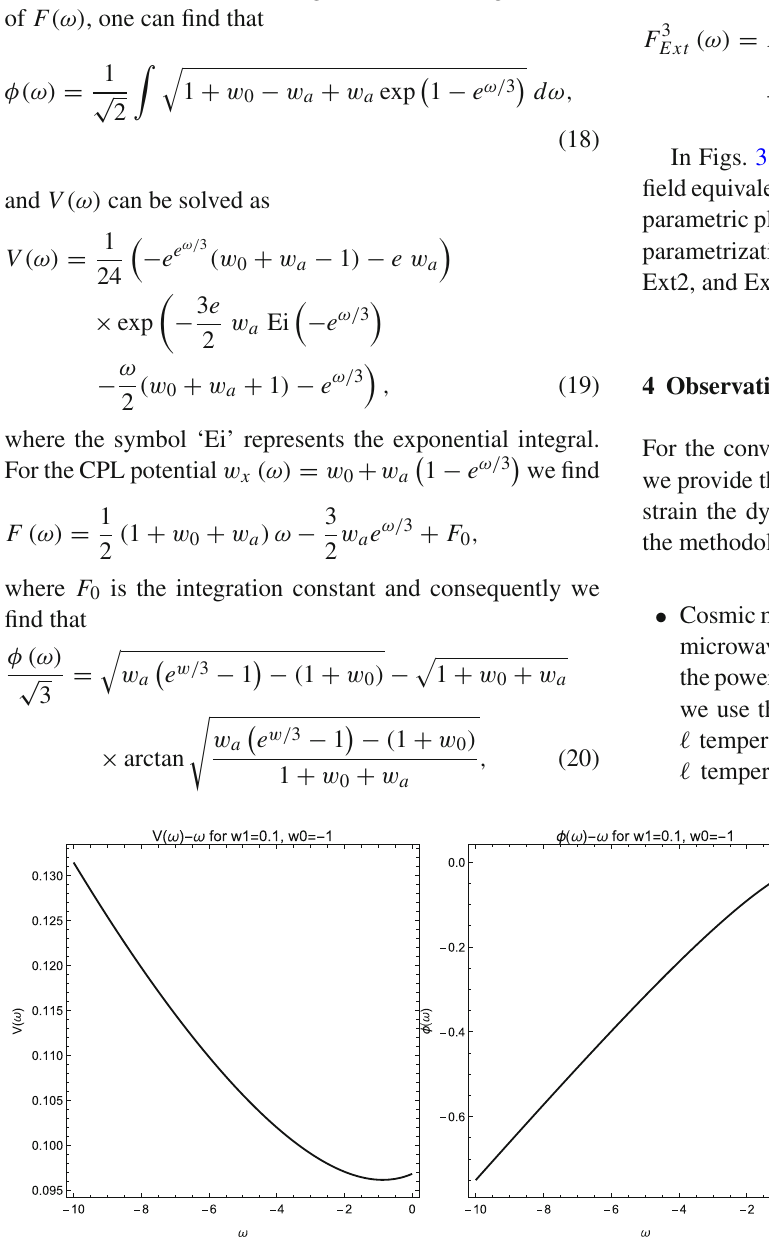
Fig. 3 Qualitative evolution of the scalar field φ (ω), the scalar field potential V (ω) as also the parametric plot φ − V (φ) is given for the CPL (Ext1)